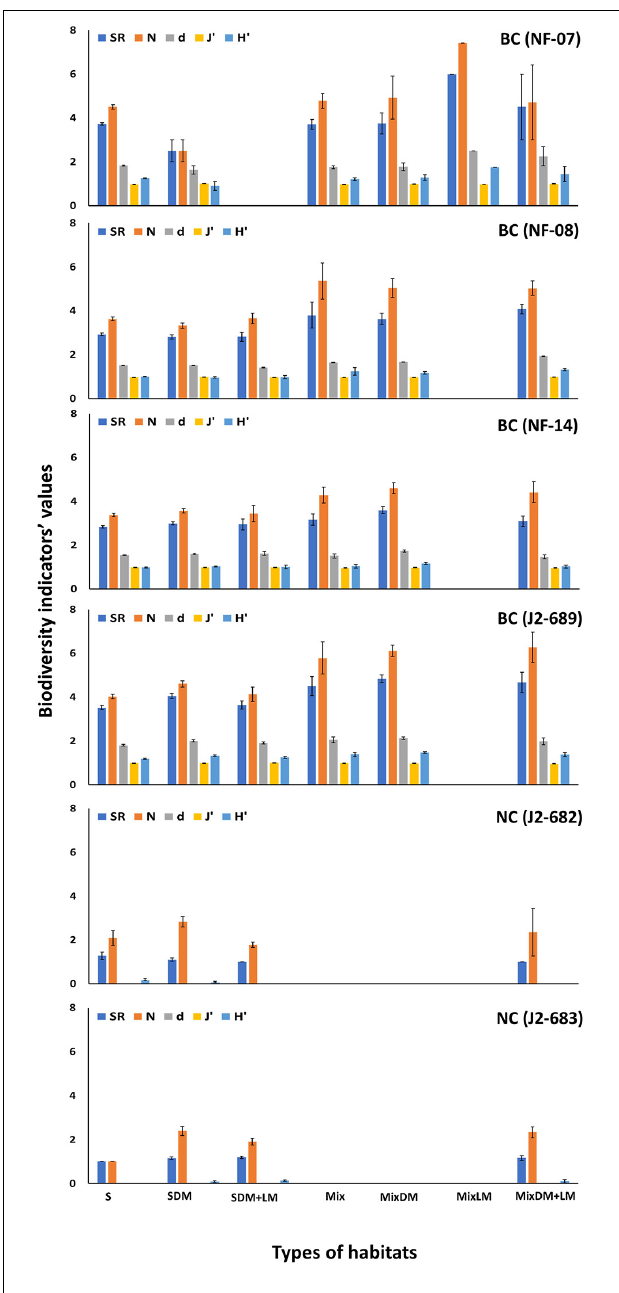
FIGURE 6 | Mean values and standard error of number of species (S), number of individuals (N), Margalef index (d), Pielou’s evenness (J (cid:48) ), and Shannon index (H (cid:48) ) across the types of habitats for each of the six ROV dives at Baltimore (BC) and Norfolk (NC) canyons. Habitat types: sand-mud (S), sand mixed with dead mussels (SDM), sand with dead and live mussels (SDM + LM), mixed hard-soft (Mix), mixed hard-soft with dead mussels (MixDM), mixed hard-soft with live mussels (MixLM), mixed hard-soft with dead and live mussels (MixDM + LM).